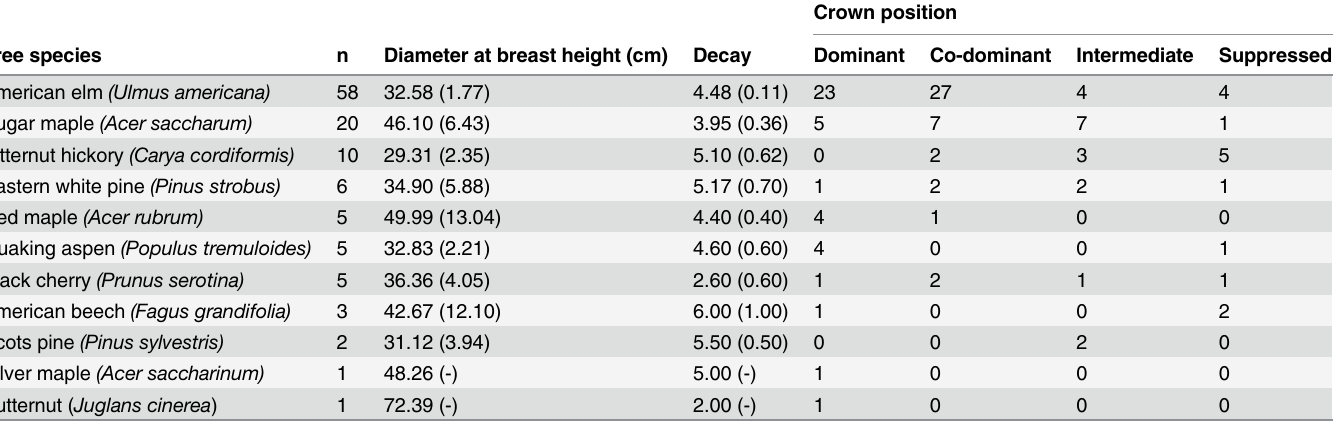
Table 2. Characteristics of 116 roost trees selected by Indiana bats at Fort Drum Military Instillation, New York, USA between 2007 – 2011. Diameter at breast height and decay class are presented as averages, with standard error values in parentheses, and crown positions are listed as tallied occurrences in each of 4 possible crown classes. Decay class values are on a scale of 1 to 8, with 1 being a healthy intact tree, 4 being a dead snag with loose bark, and 8 being a residual stump [32,33,34].